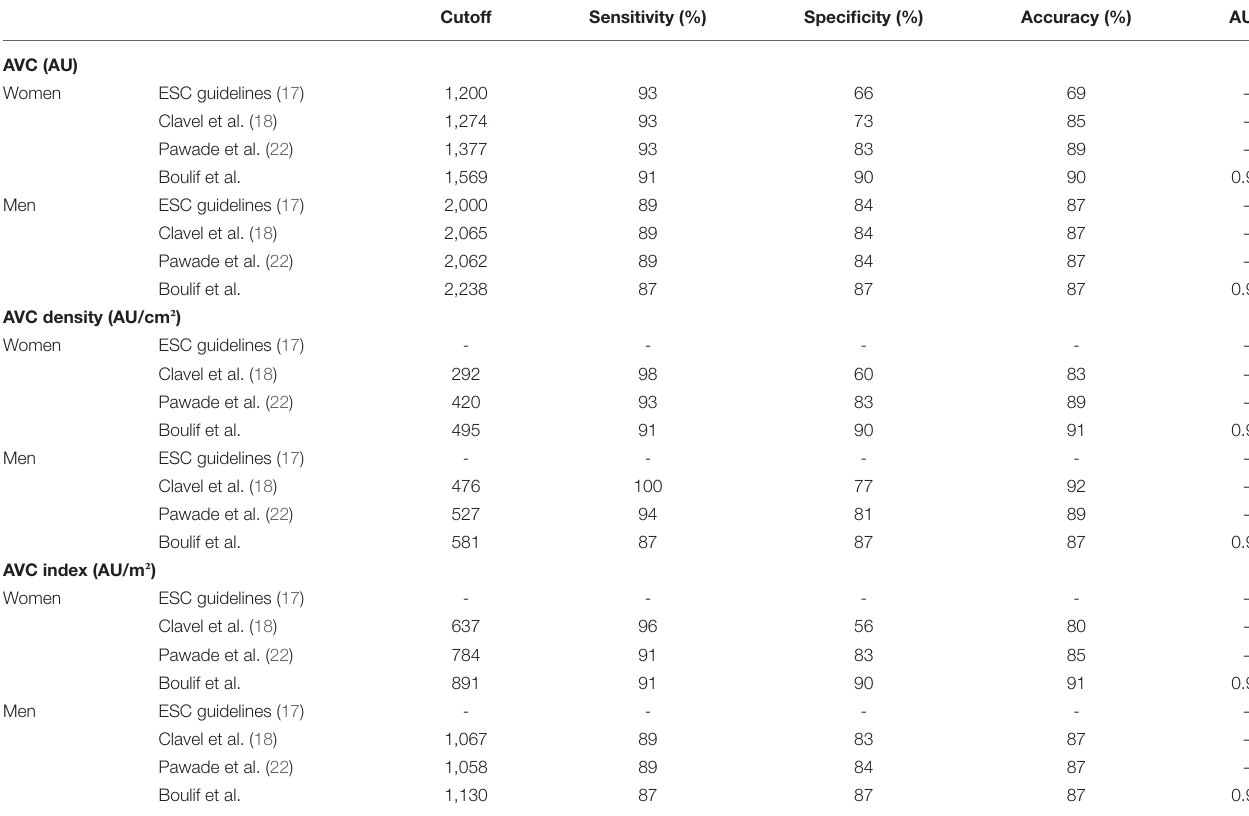
TABLE 4 | Diagnostic accuracy of severe calcification in patients with concordant echocardiographic grading.